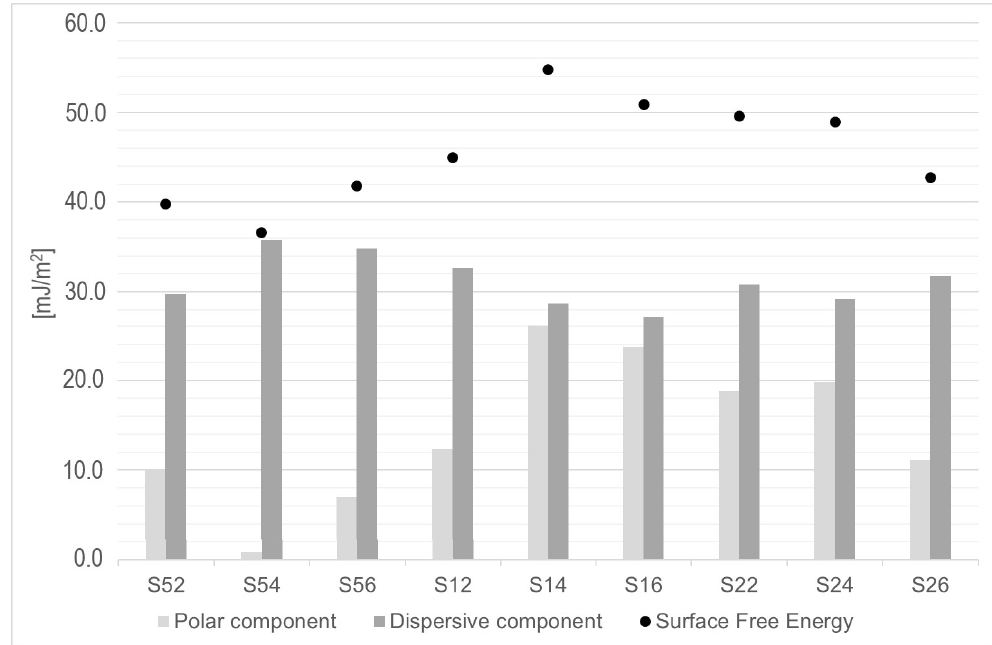
Figure 6. The polar and dispersive components and surface free energy (SFE) for the surface after SiC processing.